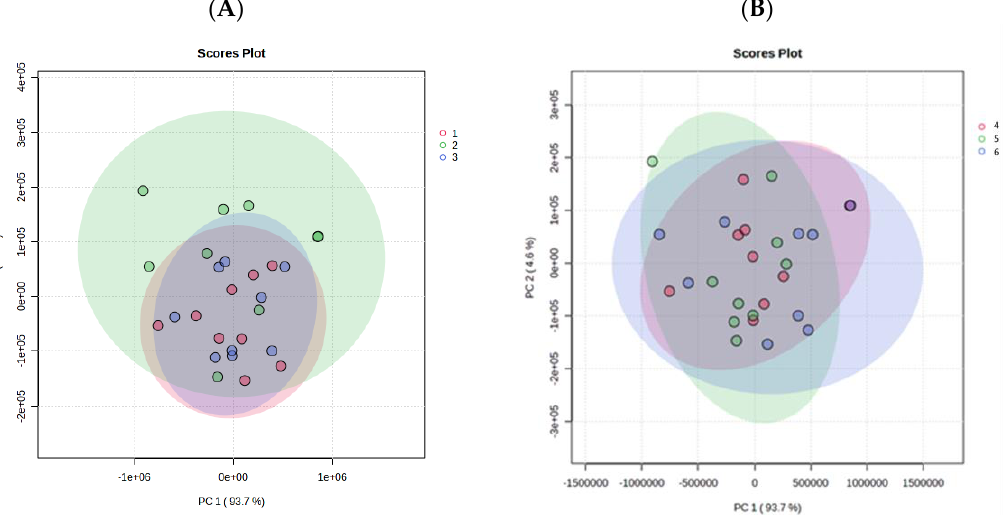
Figure 8. PCA score graph of the metabolomic study of lemon juice cultivated in 9 different treatments (3 rootstocks × 3 substrates) differentiating ( A ) depending on the substrate used and ( B ) depending on the rootstock, where 1 to 3 corresponds to the rootstock type as (1) Citrus macrophylla ; (2) Citrus aurantium ; and (3) Citrus aurantium/Citrus sinensis ; and 4 to 6 is related to the culture media: (4) 75% peat + 25% port sediment; (5) 50% peat + 50% port sediment; and (6) 25% peat + 75% port sediment.